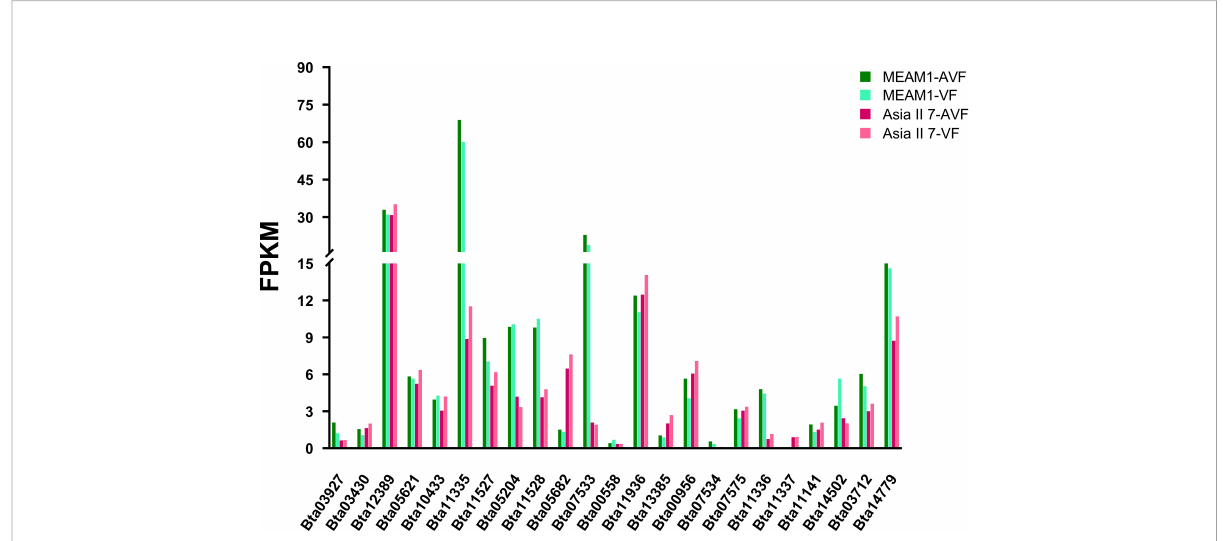
FIGURE 8 Comparative expression analysis of 23 BTB/POZ domain-containing genes among CLCuMuV-infected Asia II 7 and MEAM1 white fl ies at 12 h